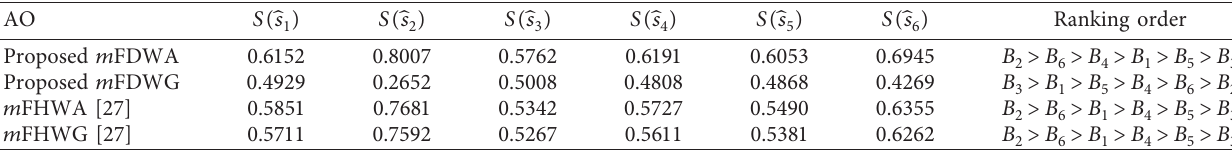
Table 7: Comparison of m F Dombi AOs with m F Hamacher AOs [27] in bank selection.